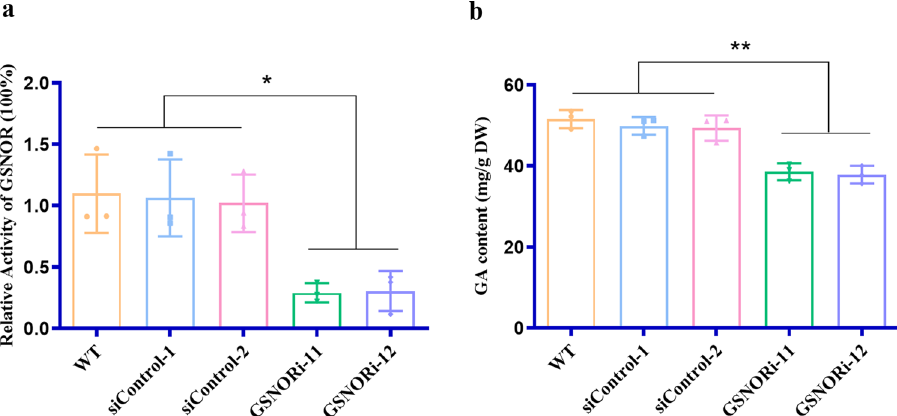
Fig. 1 GSNOR activity and GA content in the WT and GSNOR-silenced strains. a Protein extracts were prepared from WT and GSNORi mycelia samples, and GSNOR activity was measured as the consumption of NADH in the supernatants via absorbance at 340 nm. b The WT strains and GSNOR-silenced strains were grown for 5 days in PDA liquid cultures with shaking and then exposed to 42 °C for 12 h and shifted to 28 °C until the 7th day in stationary. The GA contents were measured in the heat-stressed strains. Data are presented as the mean ± SD based on three independent experiments (* P < 0.05, ** P < 0.01 by one-way